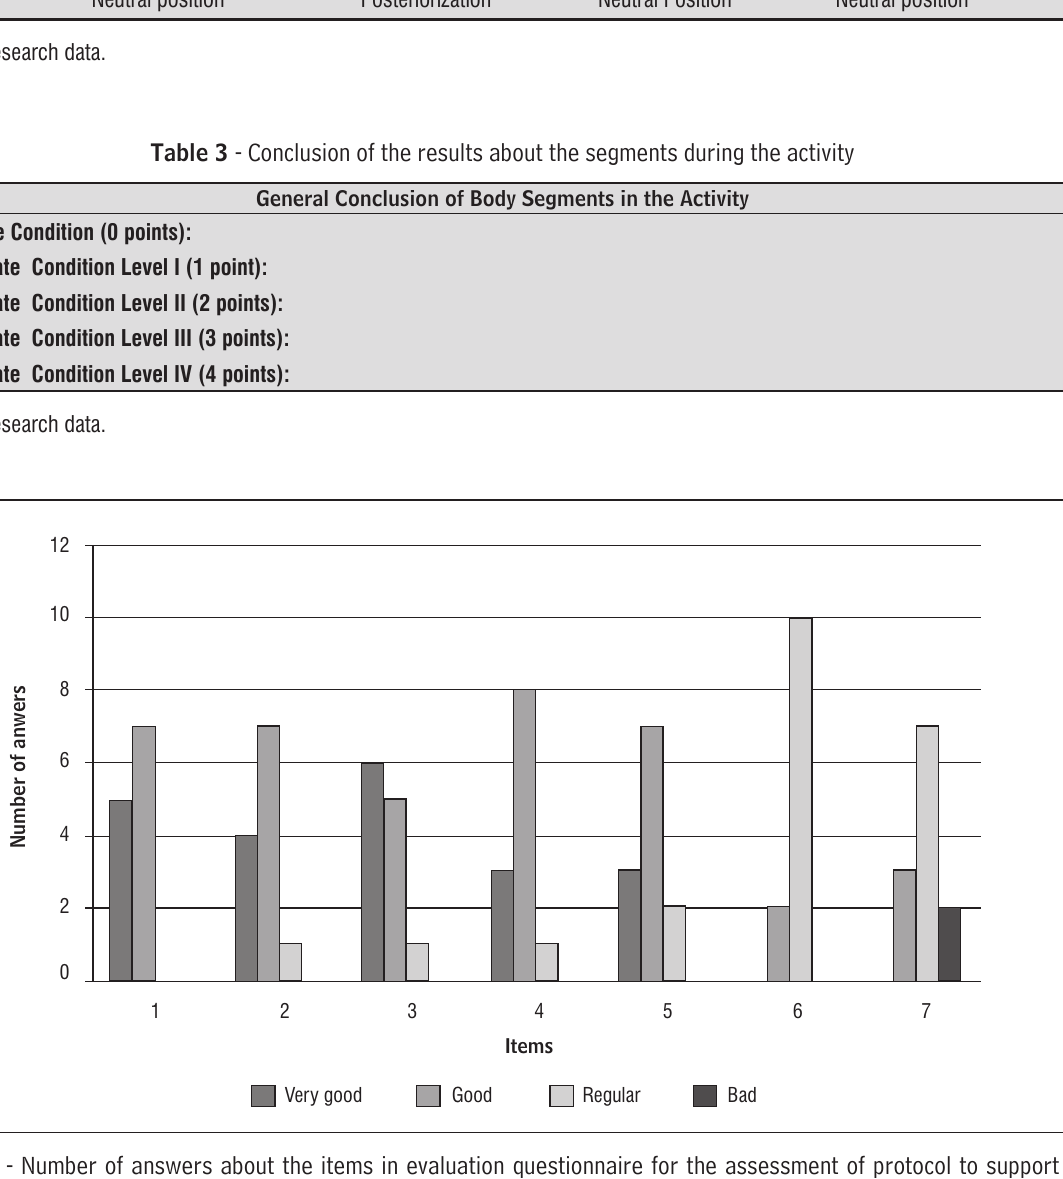
Figure 1 - Number of answers about the items in evaluation questionnaire for the assessment of protocol to support the evaluation of stand-to-sit activity in